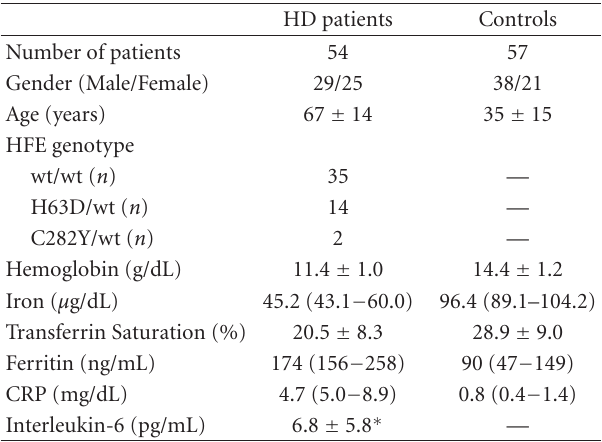
Table 1: Clinical features and baseline laboratory